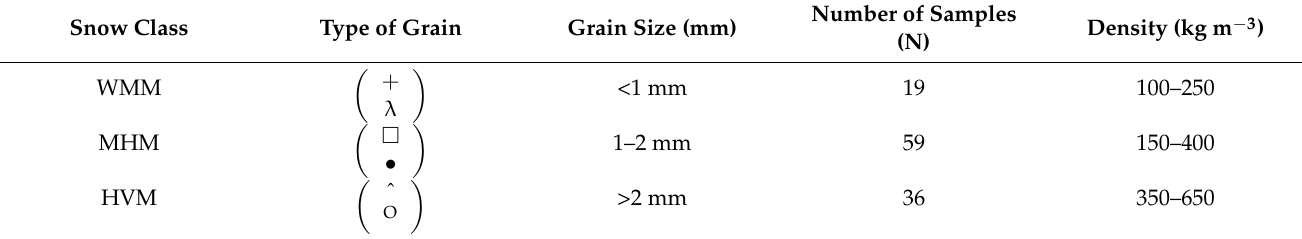
Table 2. Distribution of snow density as a function of snow grain type and size (field data: 2018, 2019 and 2020